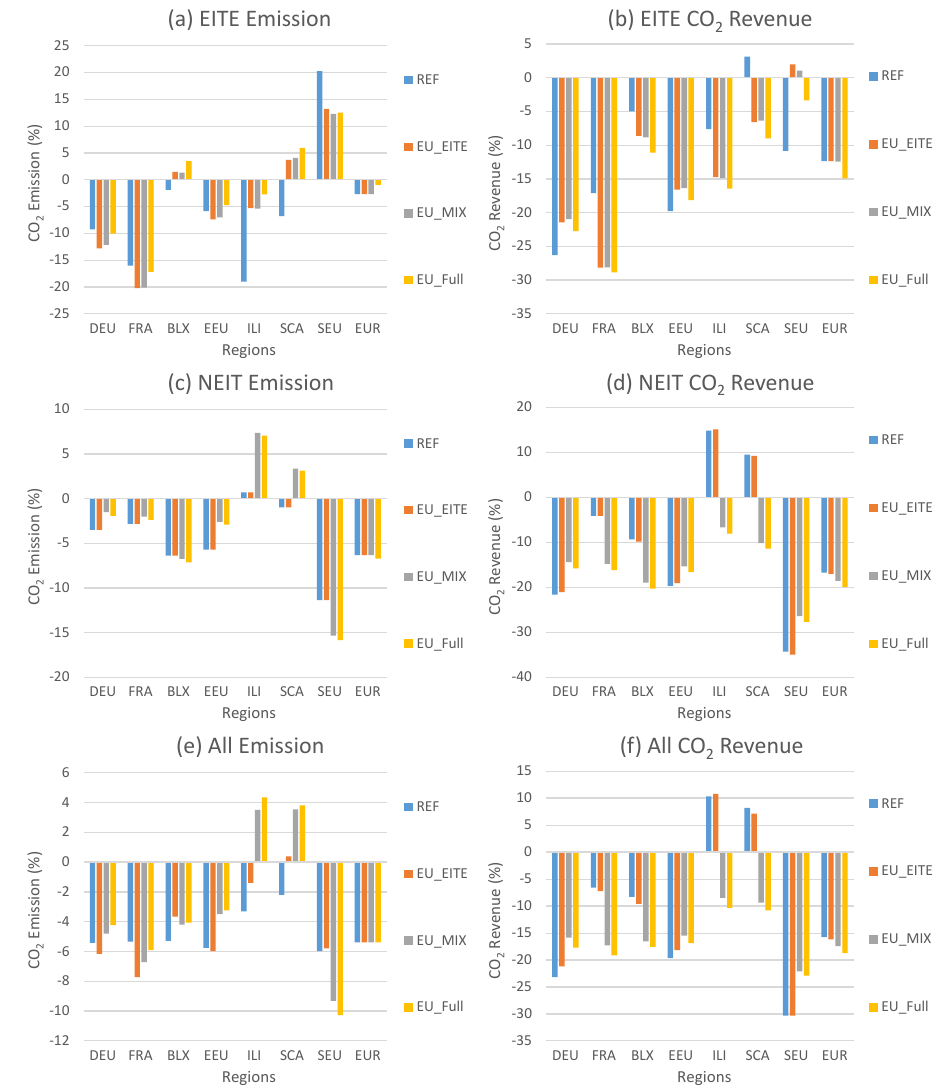
Figure 10. Percentage change in CO 2 emission and CO 2 revenues for different policy scenarios using the WEO baseline against the IEO baseline.